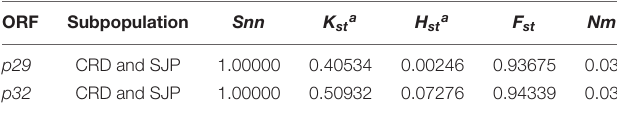
TABLE 6 | Population genetic differentiation analysis based on ORFs p29 (795 nts) and p32 (288 nts, partial) of CiLV-C. ORF